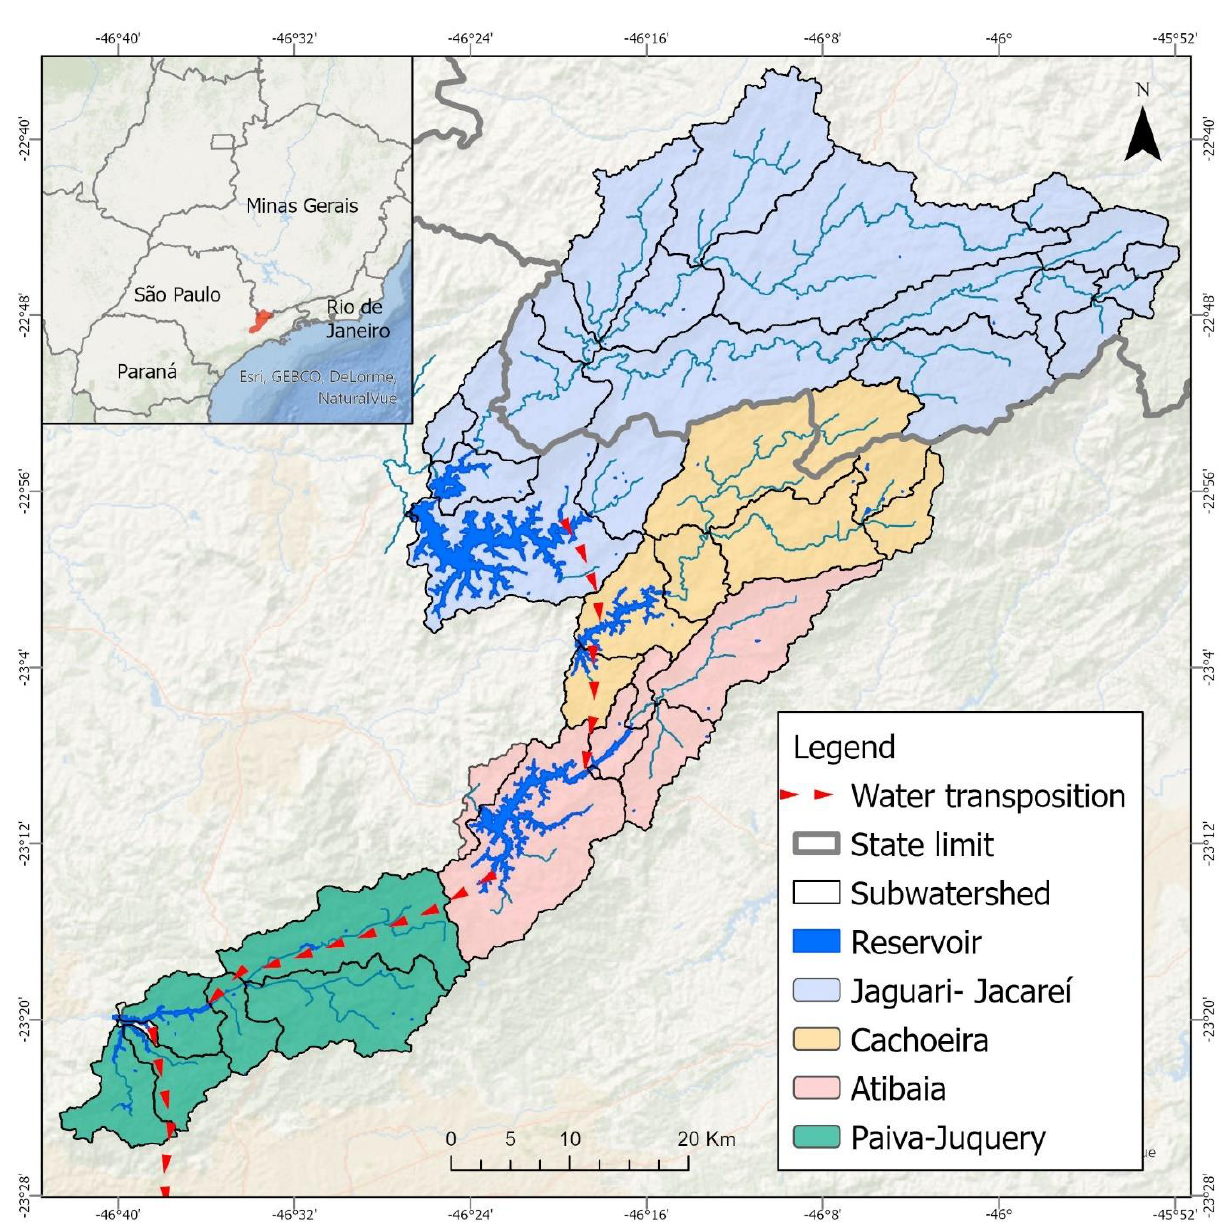
Figure 1. Geographic scope of the modeling exercise includes five subwatersheds and reservoirs of the Cantareira system. Red dotted line shows the direction of water transposition.